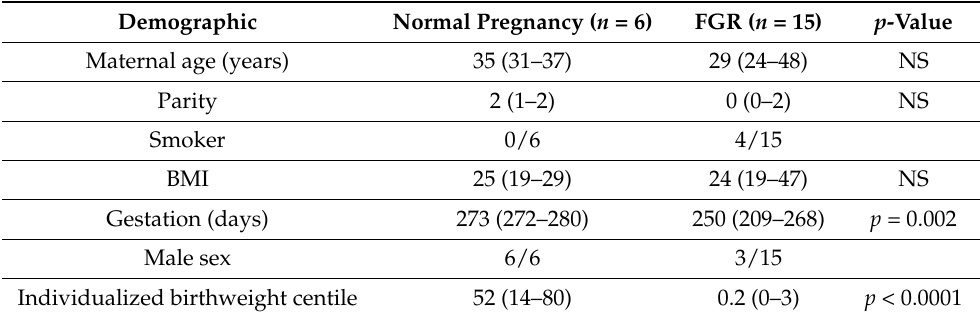
Table 1. Patient